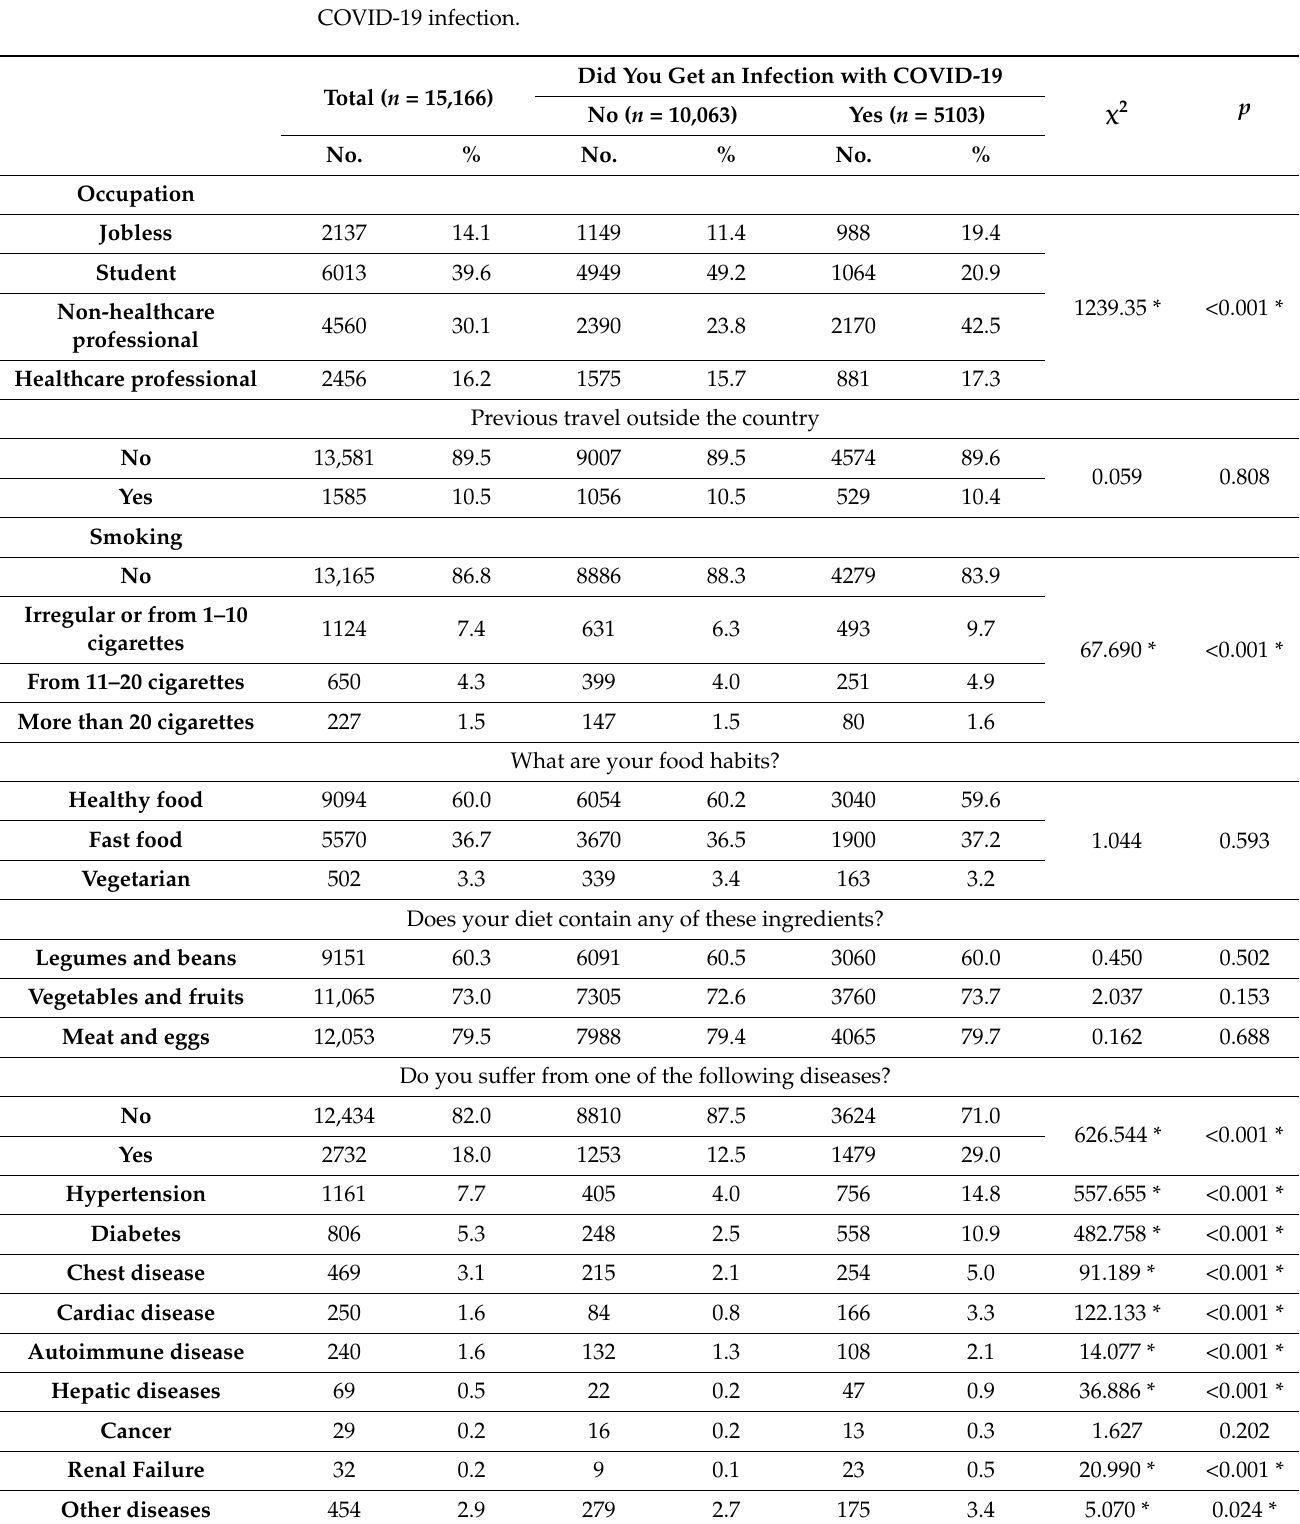
Table 3. Impact of social, nutritional risk factors, and comorbid health status on the incidence of COVID-19